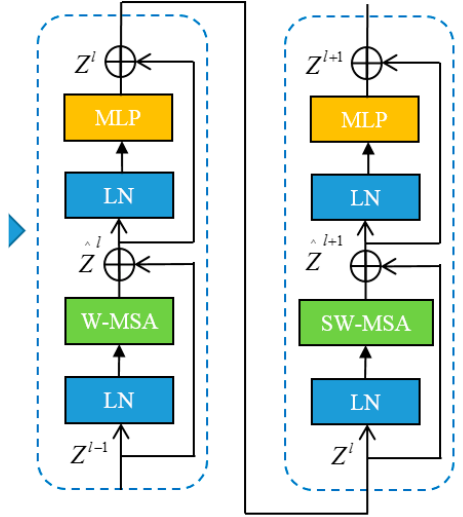
Figure 3. The architecture of the two blocks of the Swin Transformer.